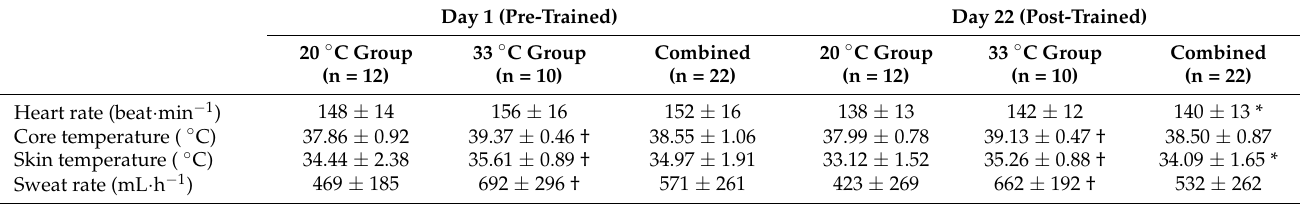
Table 3. Fixed-Intensity Temperature Tolerance Trial Data (20 ◦ C or 33 ◦ C). Day 1